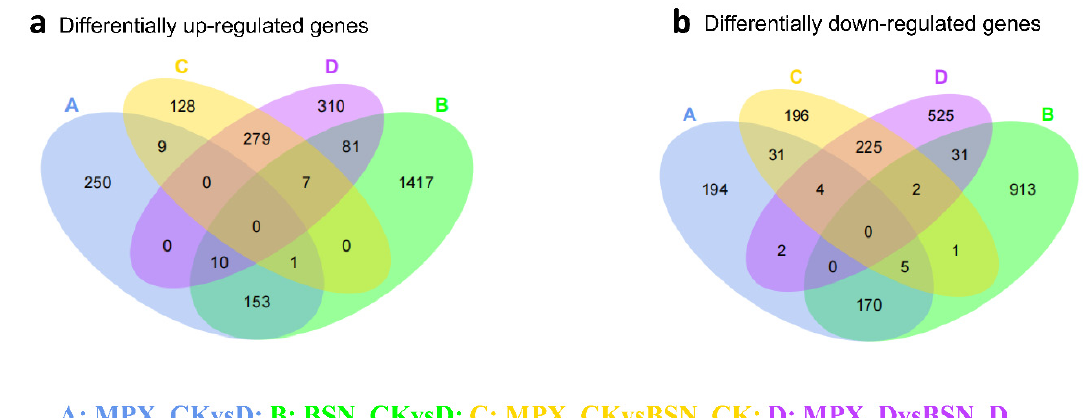
Figure 3. Venn diagrams of differential genes. ( a ) Venn diagram of shared and non-shared upreg- ulated number of genes in MPX and BSN of the treatment group and the control after 21 days of drought. ( b ) Similar to panel ( a ) but for downregulated genes.